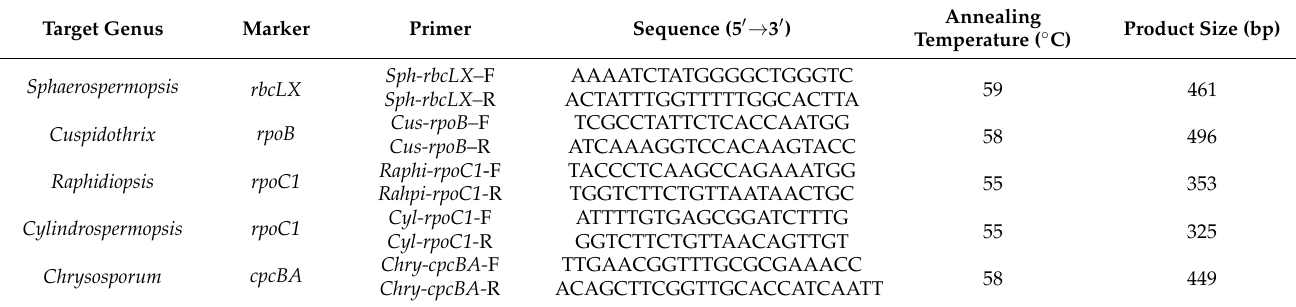
Table 3. Genus-specific primers developed in this